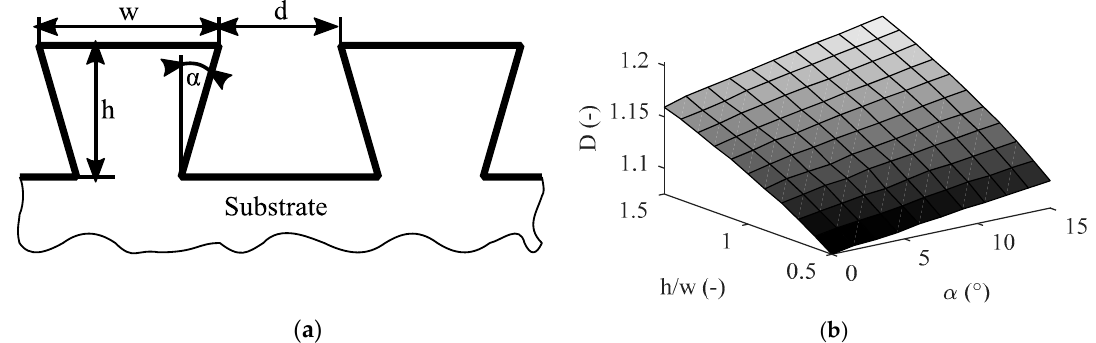
Figure 4. Dovetail structure: ( a ) schematic representation and ( b ) D in dependence of undercut angle α and height-to-width ration h/w ( w/d = 2.0).